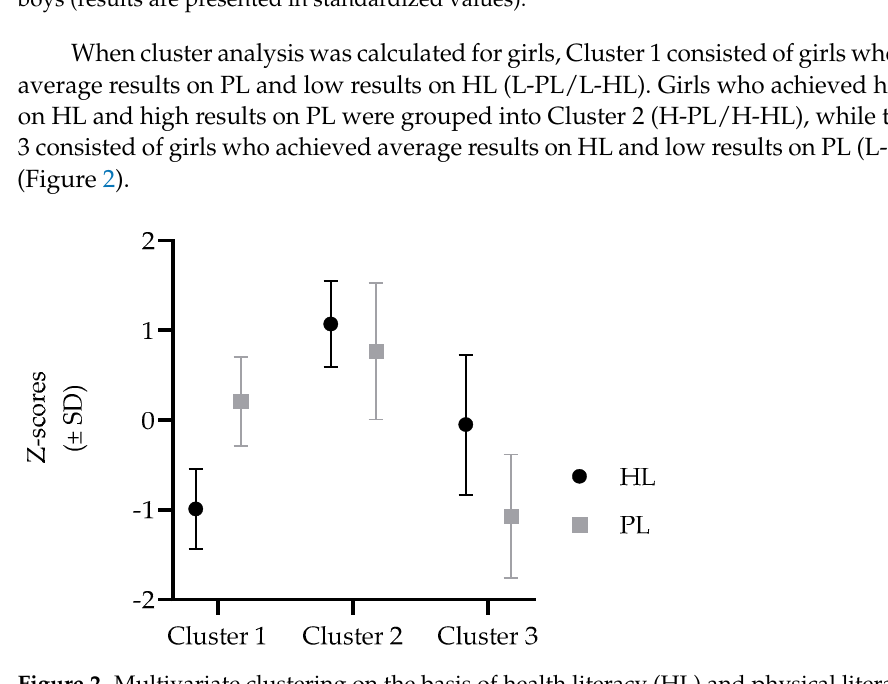
Figure 1. Multivariate clustering on the basis of health literacy (HL) and physical literacy (PL) for boys (results are presented in standardized values).